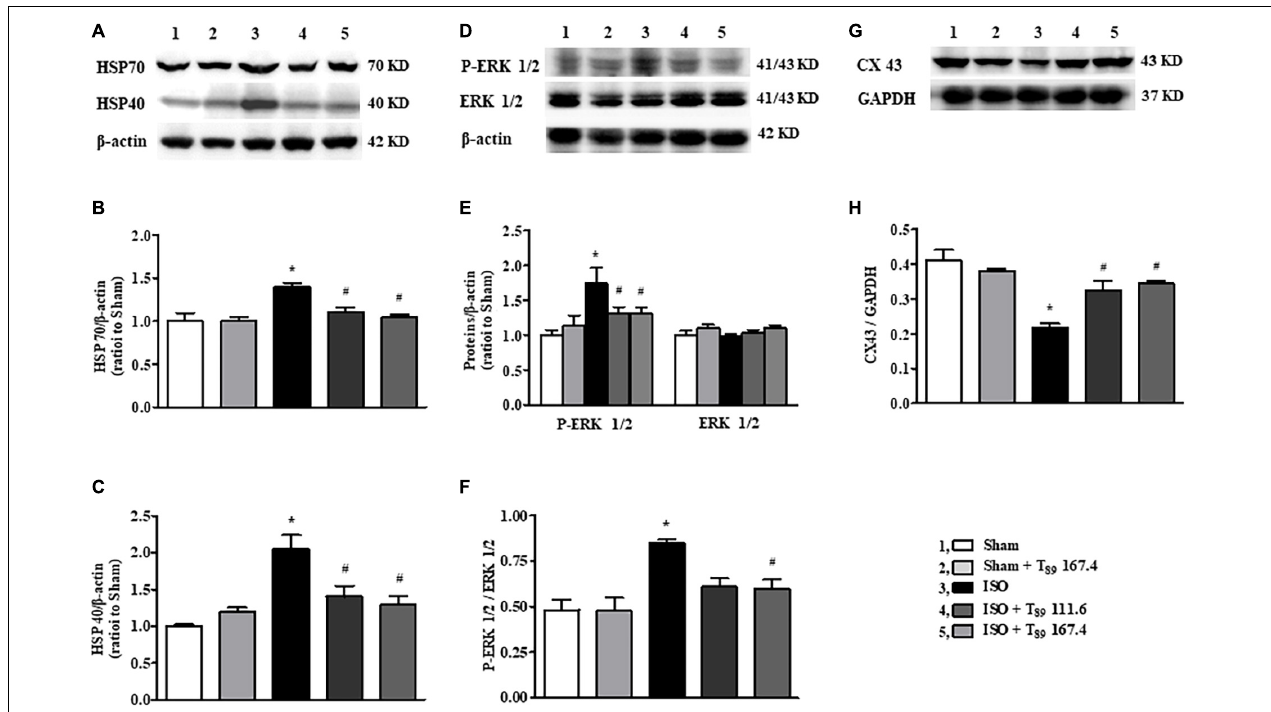
FIGURE 6 | Effect of T 89 on ISO-induced alteration in HSP70, HSP40, ERK 1/2, and CX43. (A–C) Western blotting validation of HSP70, HSP40, and corresponding quantitative evaluation in different groups. n = 4. (D – F) Representative Western blotting bands of P-ERK1/2, ERK 1/2, and the quantitative evaluation in different groups. n = 4. (G , H) Representative Western blotting bands and the quantitative analysis of CX43 in different groups. n = 4. * P < 0.05 vs. Sham group, # P < 0.05 vs. ISO